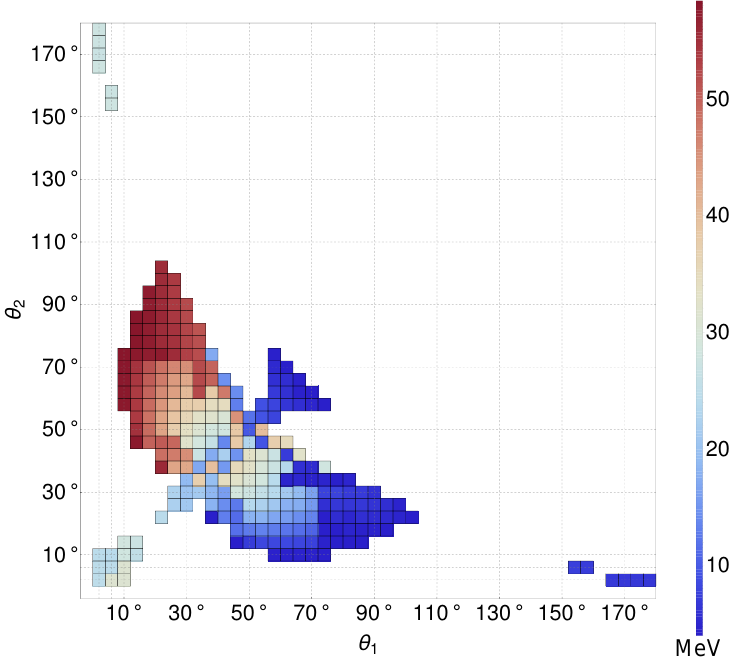
Figure 6: The distribution of the outgoing neutron energy E responded to the maximal ∆ SIGS in the cross section distribution (see Fig. 4) for the deuteron breakup process at E = 65